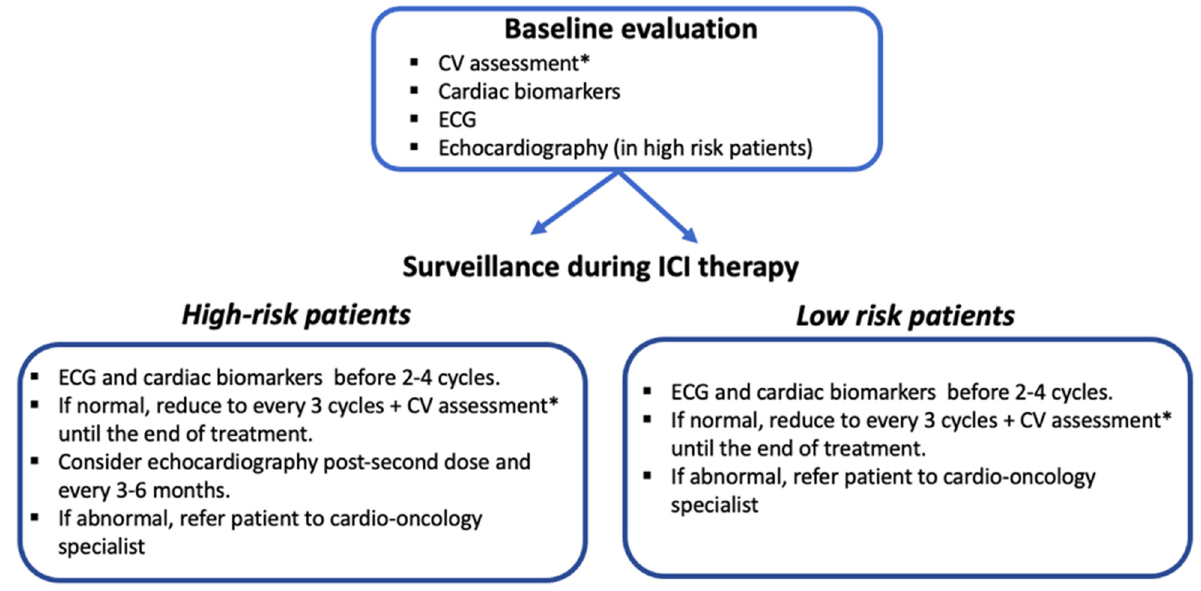
Figure 3. A proposed surveillance strategy in patients undergoing ICI therapy. BNP, brain natriu- retic peptide; CV, cardiovascular ECG, electrocardiogram; NT-proBNP, N-terminal pro-brain natriuretic peptide. * consists of a physical examination as well as blood pressure, lipid profile, and HbA1c determinations [18].